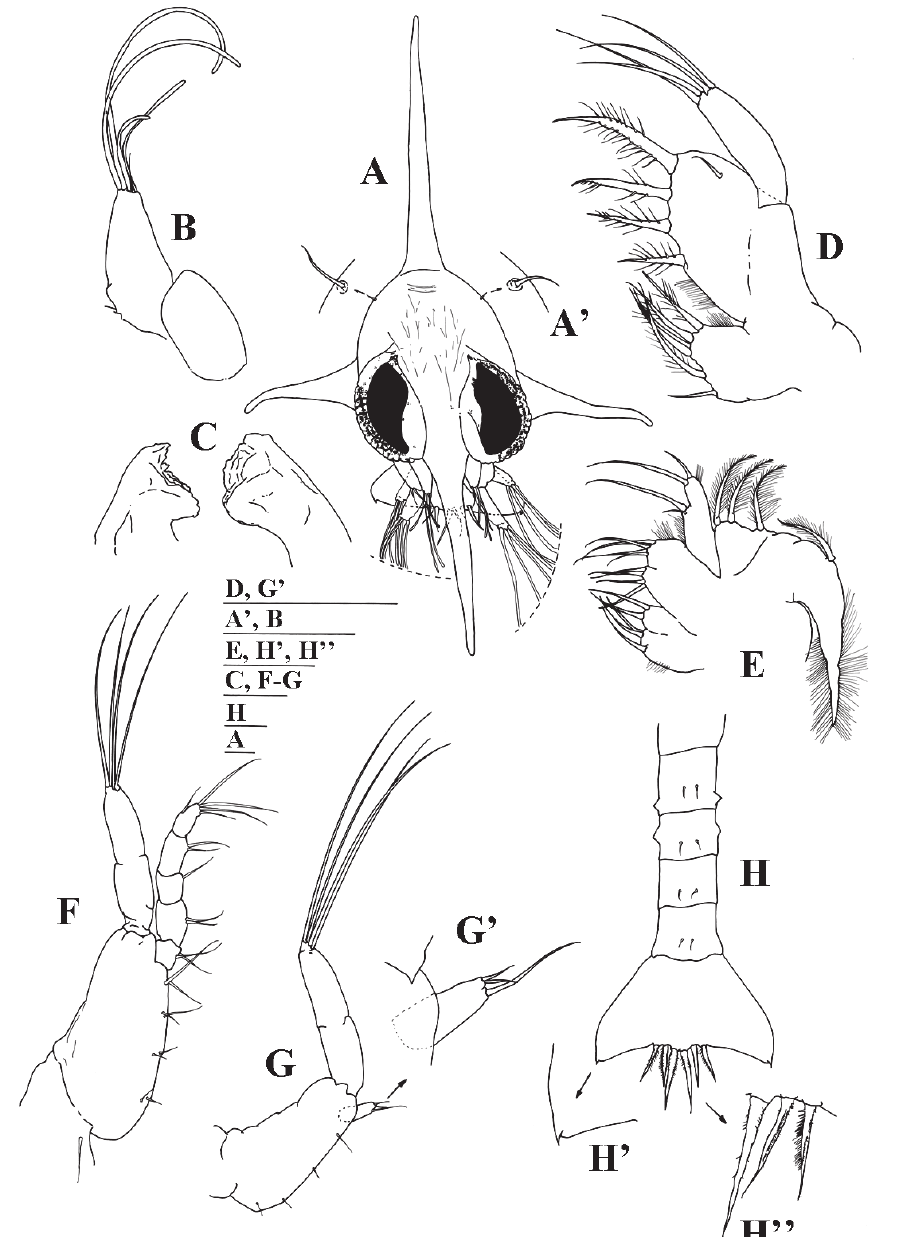
Fig . 1. – Ilia nucleus . First zoea: a, general aspect, frontal view; a’, detail of setae on carapace; B, antennule and antenna; C, mandibles; d, maxillule; e, maxilla; F, first maxilliped; g, second maxilliped; g’, detail of second maxilliped endopod; H, dorsal view of abdomen and telson; H’, detail of furcal spine; H’’, detail of furcal setae. scale bars: 0.1